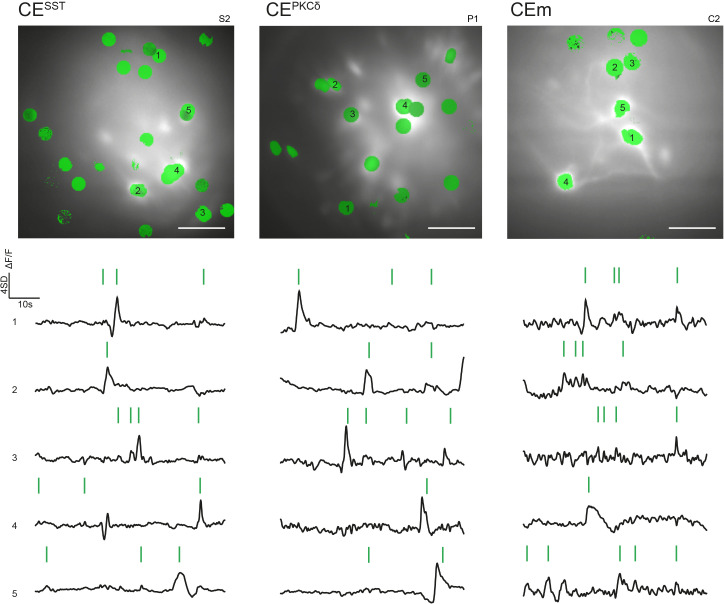
Representative FOVs and activity from CE calcium imaging.Green overlay corresponds to automatically detected and manually selected units to exclude artifacts. Scalebar = 100 µm (top). Five representative traces from each FOV with detected calcium events in green. Vertical scalebar corresponds to four standard deviations of ΔF/F calcium signal, horizontal scalebar corresponds to 10 s (bottom).